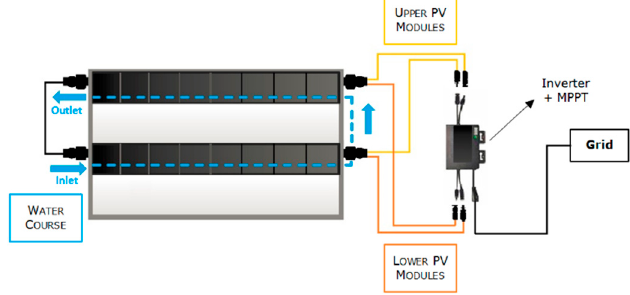
Figure 3. Schematics of the PowerCollector ™ electrical installation.